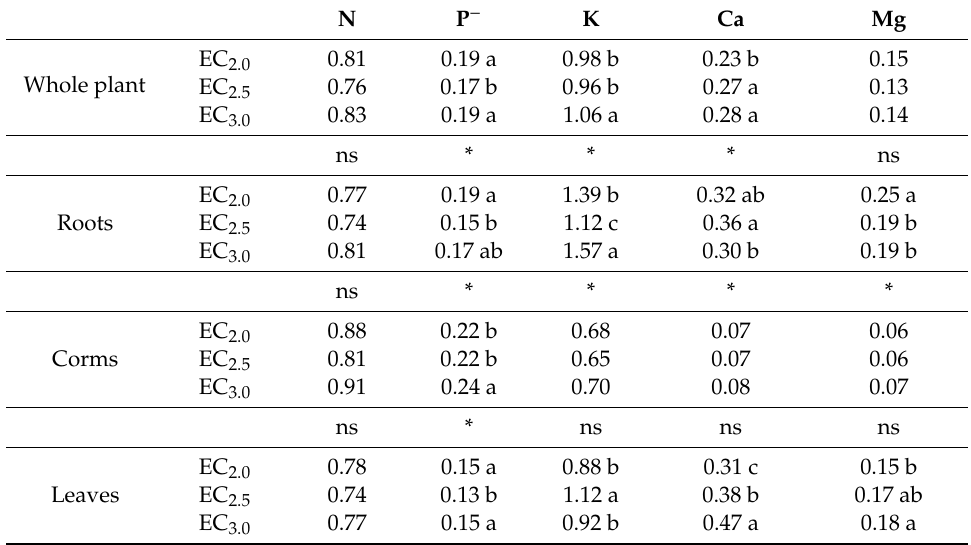
Table 3. Total contents of elements (% DM − 1 ) in roots, corms and leaves of sa ff ron grown in perlite, with three EC levels in fertigation solutions 2.0 (EC 2.0 ), 2.5 (EC 2.5 ) and 3.0 (EC 3.0 ) dS · m − 1